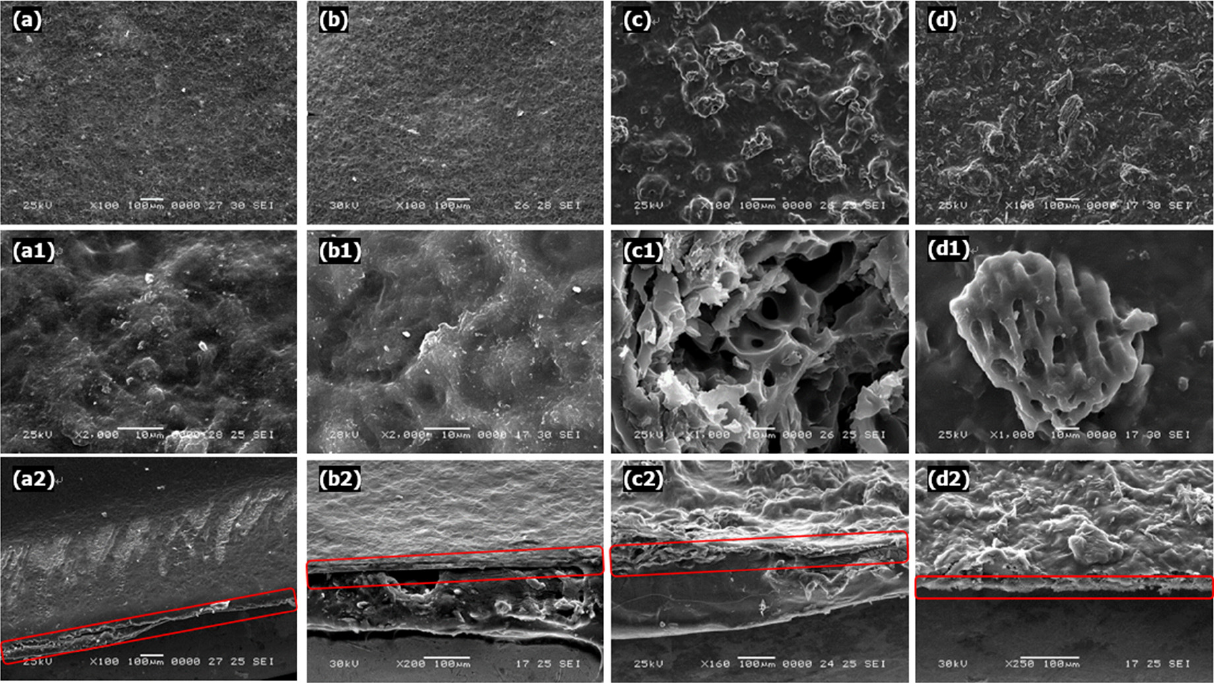
Figure 2. SEM of micrograph from surface of films (wavelength 100 µ m and magnification × 100) ( a ) CS, ( b ) CS/ESP, ( c ) CS/ESP/OPAC and ( d ) CS/ESP/CAC film; ( a1 ) CS and ( b1 ) CS/ESP (wavelength 10 μ m and magnification × 2000); ( c1 ) CS/ESP/OPAC and ( d1 )CS/ESP/CAC (wavelength 10 μ m and magnification × 1000); the cross sectional view of films shows in the red box ( a2 ) CS film, ( b2 ) CS/ESP film, ( c2 ) CS/ESP/OPAC film, and ( d2 ) CS/ESP/CAC film.